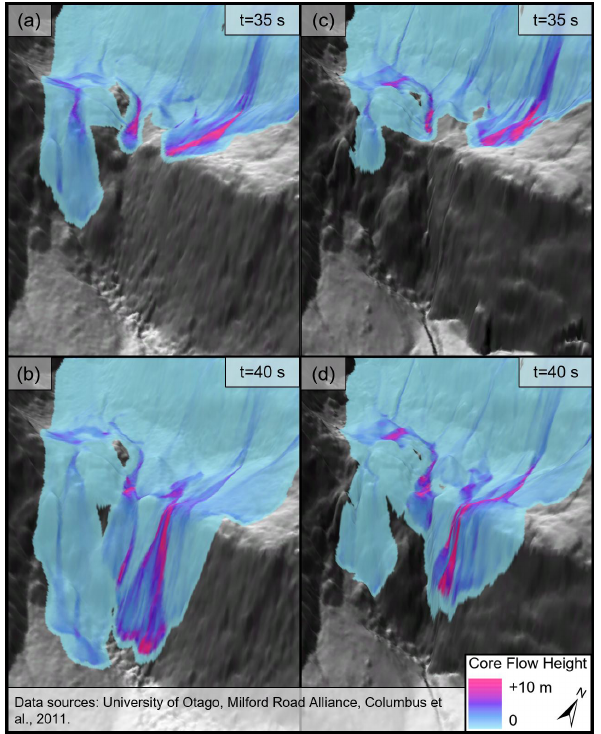
Figure 12. Composite map showing the estimated core flow height at two time steps for both the TLS and SPM 2m DSMs. Panel (a) shows the SPM DSM and panel (c) shows the TLS DSM both at t = 35s in the simulation. Panel (b) shows the SPM DSM and panel (d) the TLS DSM at t = 40s in the simulation. For spatial context, the cliff face shown in the composite is approximately 200m in